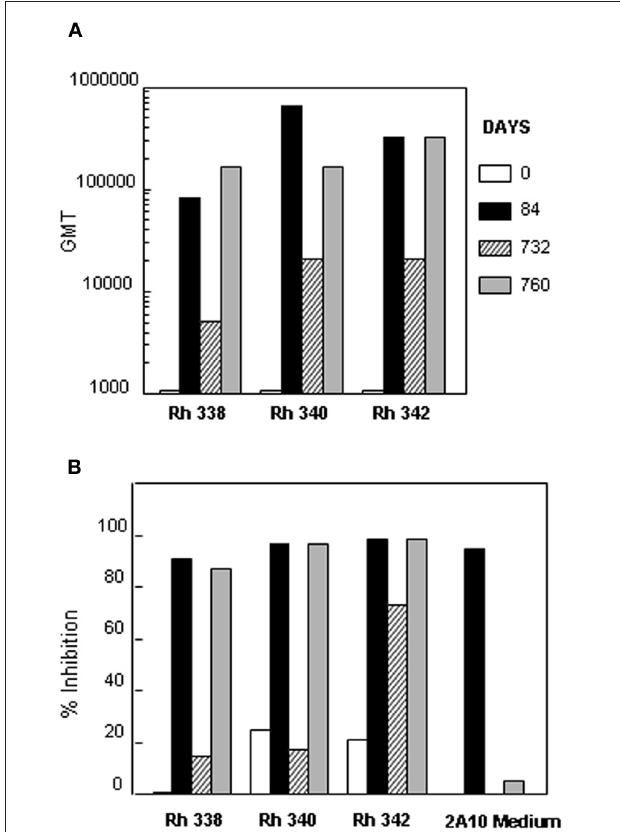
FIGURE 7 | Sporozoite neutralizing activity in immune sera of rhesus macaques. Sera was collected from three rhesus macaques at days 0, 84, 732, and 760 post immunization with (NANP) 6 -OMPC/MAA + Iscomatrix®. (A) Sera were tested in ELISA with results shown as anti-repeat GMT. (B) TSNA was carried out using 1:5 serum dilution with results shown as mean % Inhibition of PfPb sporozoite invasion of HepG2 cells.